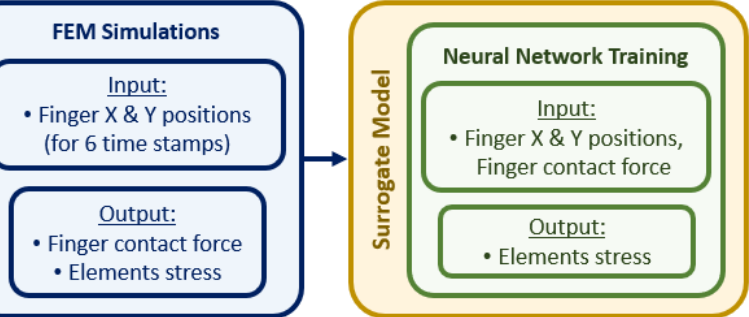
Figure 5. Flowchart on the use of information gathered from the FEM simulations to construct the surrogate model for effective ANN training.